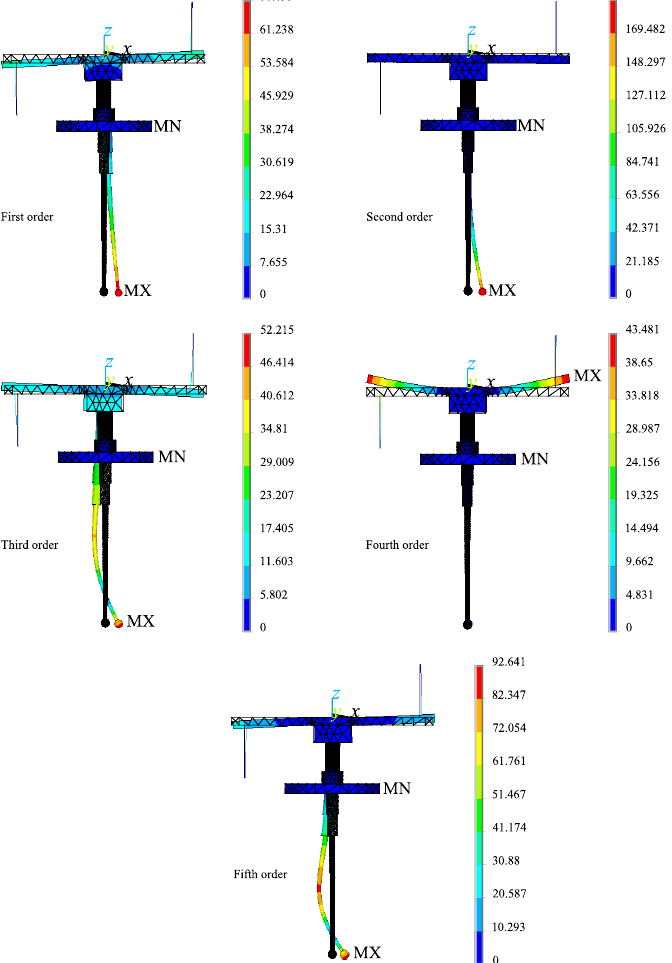
Figure 9. Vibration modes of the armature assembly with MF in the working